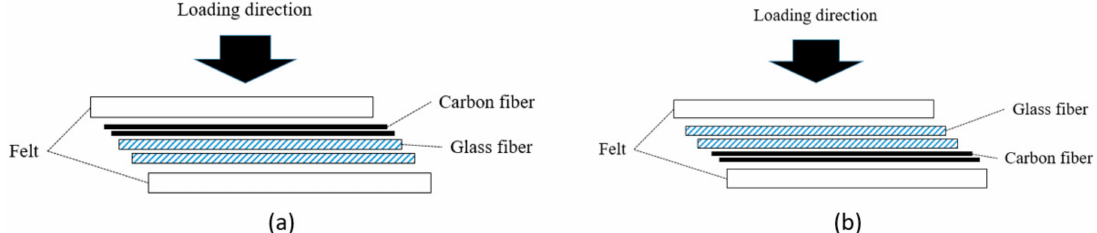
Figure 2. Carbon Fiber and Glass Fiber Composite Layers for Three Point Test: ( a ) Carbon fiber layered at the top of the composite and ( b ) Carbon fiber layered at the bottom of the